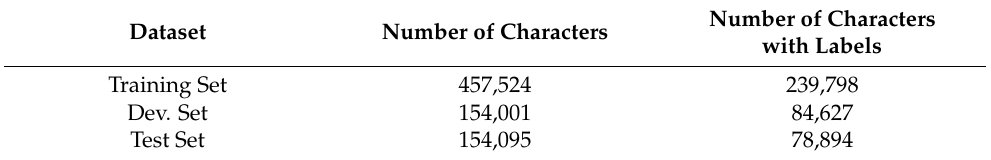
Table 6. Dataset structure of typhoon